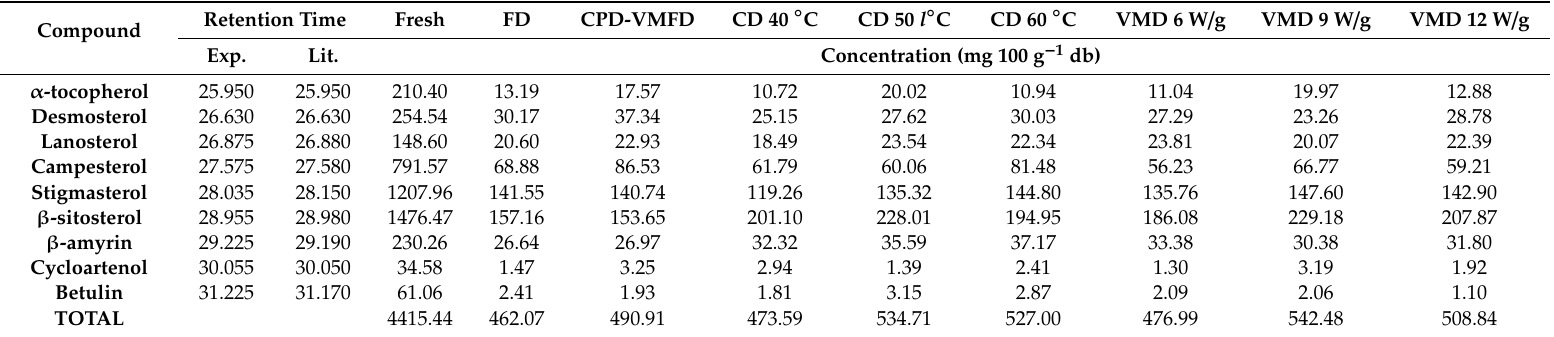
Table 3. Concentration of phytosterols influenced by drying methods.